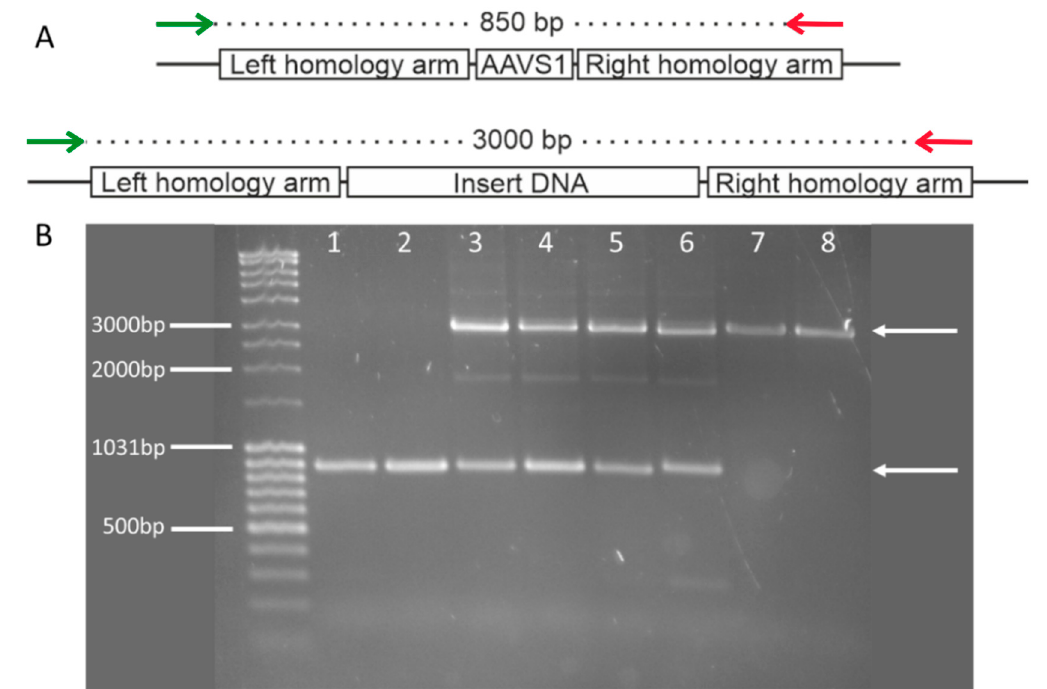
Figure 2. Summary of insert confirmation PCR ( A ) Summary of the Cas9 induced double-strand break, the consequential integration of the donor DNA into the AAVS1 safe harbor locus by homology-driven recombination, and the locations of the primer pair designed to amplify the genetic area surrounding the AAVS1 safe-harbor locus. The forward primer (green) is located in the flanking region 5 ′ of the left homology arm, the reverse primer (red) is located within the right homology arm. The wild-type (WT) confirmation amplicon has an expected product size of 850 bp and the insert confirmation amplicon has an expected product size of 3000 bp. ( B ) Amplification of the region surrounding the AAVS1 safe harbor locus in non-transfected SiMa (lane 1), non-transfected IMR90-4 (lane 2), SiMa clones 1–3 (lanes 3–5), and IMR90-4 clones 1–3 (lanes 6–8). The appropriate amplicon sizes are marked by white arrows and are found at 850 bp for the WT allele and 3000 bp for the allele containing the insert.